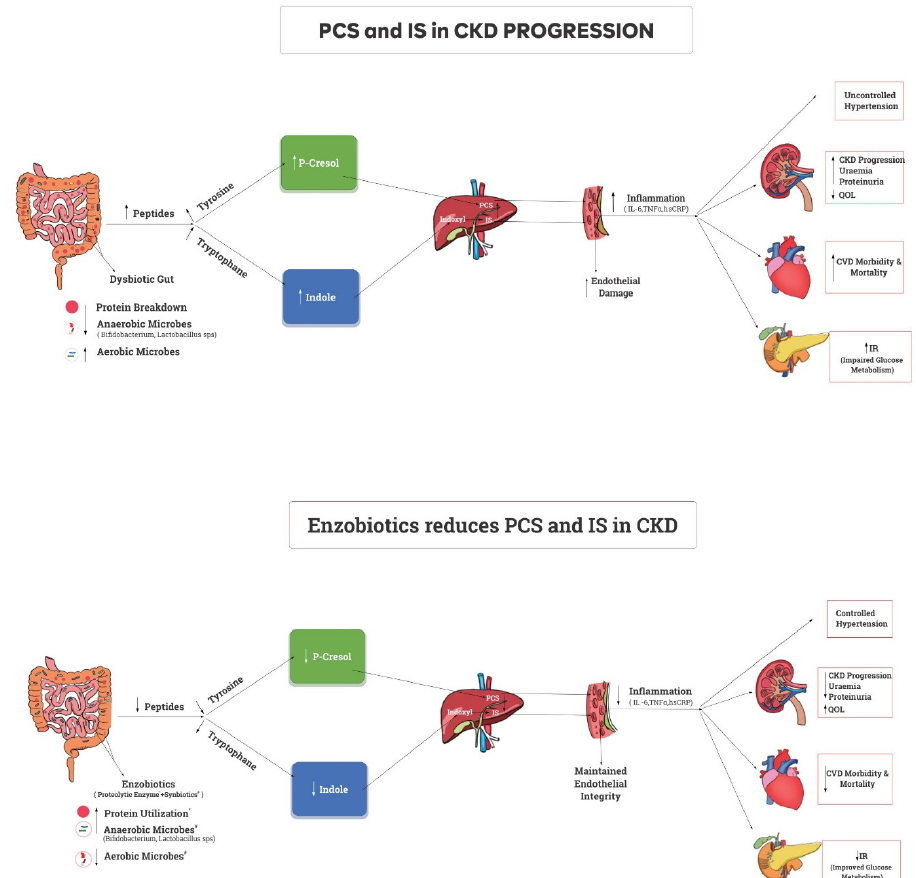
Figure 1. A dysbiotic gut with inadequate protein metabolism contributes to the increased inflamma- tory state responsible for CKD progression, morbidity, and mortality. Supplementation of enzobiotics (synbiotics + proteolytic enzymes) with food ensures complete protein metabolism in a eubiotic environment, thus reducing the inflammatory state and leading to better outcomes in CKD rat model [27].